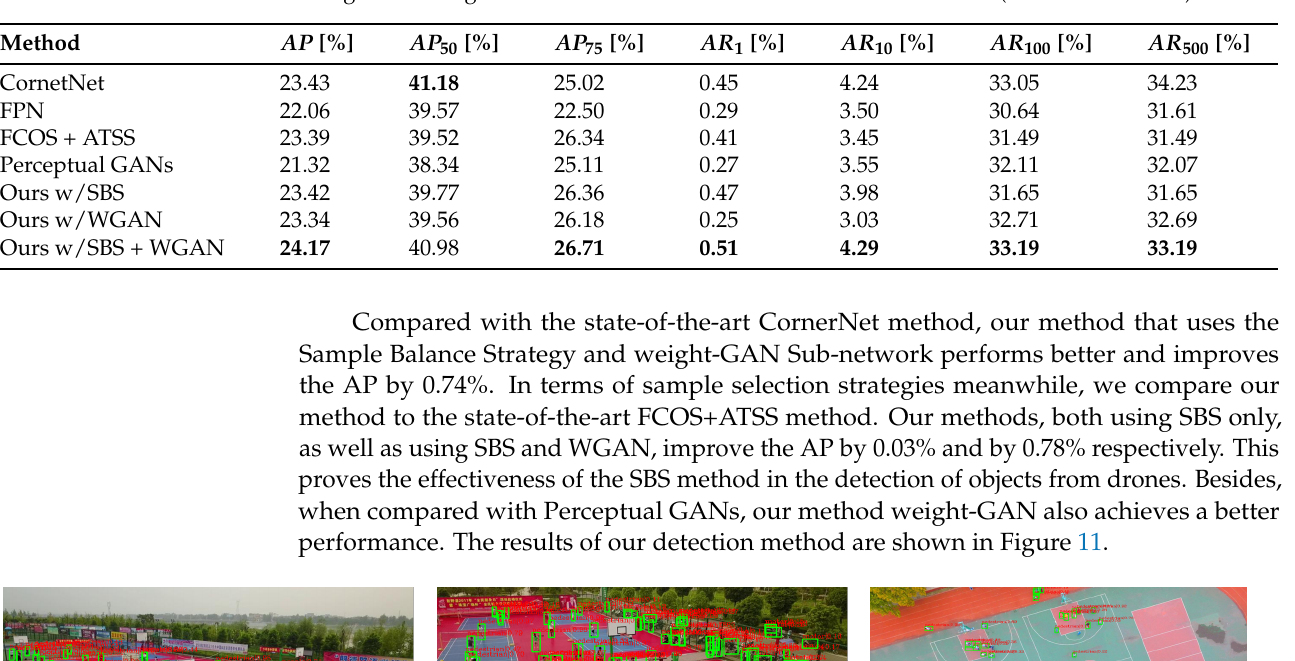
Table 4. A table for calculating the training AP and AR of different models for the same dataset (Visdrone2020-dev).